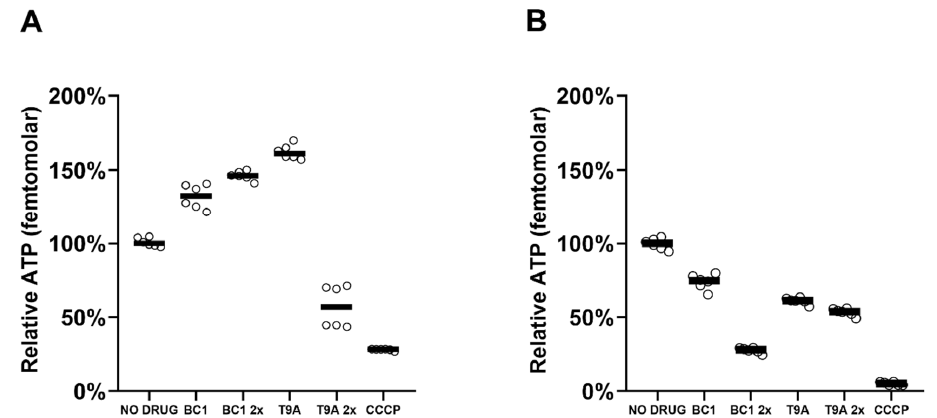
Figure 4. ATP concentration (relative light units): ( A ) after 30 min treatment of B. subtilis cells and ( B ) after 80 min treatment of X. citri cells, with 1x and 2x the MIC of BC1 or T9A or 40 μ g/mL of CCCP. 100% is defined as the median luminescence of the control sample (without any compound added); each circle represents a replicate, and bars indicate the median of each condition tested.